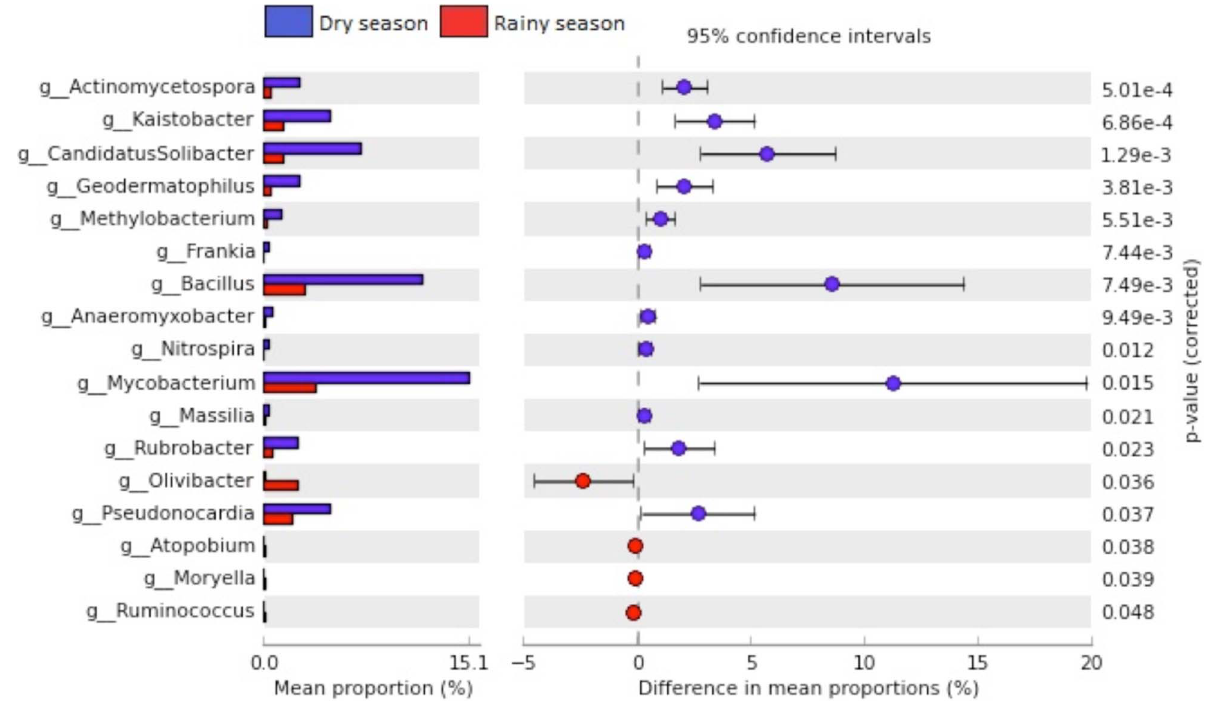
Figure 8. The seventeen most significant genera (p , 0.05) with respect to the season. Figure S1 Clustering analysis of sampling sites, using UPGMA with Euclidian distance. Comparison during the rainy season (RS) and dry season (DS) for bulk soil samples (SL) for the five different sampling points: # 1, # 2, # 3, # 4 and # 5. (TIF) Figure S2 Non-metric multidimensional scaling (NMDS) of bacterial communities determined by T- RFLP, showing the spatial variation (A) and source variation (B and C). Bulk soil samples are represented by circles and rhizosphere samples are represented by squares. Rainy season is represented by the white color and dry season is represented by the black color. The five different sampling points are represented by a cross ( # 1), a white triangle ( # 2), an x ( # 3), a black triangle ( # 4), and a rectangle ( # 5). (TIF) Figure S3 Clustering analysis using Ward’s method obtained from 16S rRNA sequences showing a clear division according to the season. Dry season samples (DS) form one cluster, while rainy season samples (RS) form two